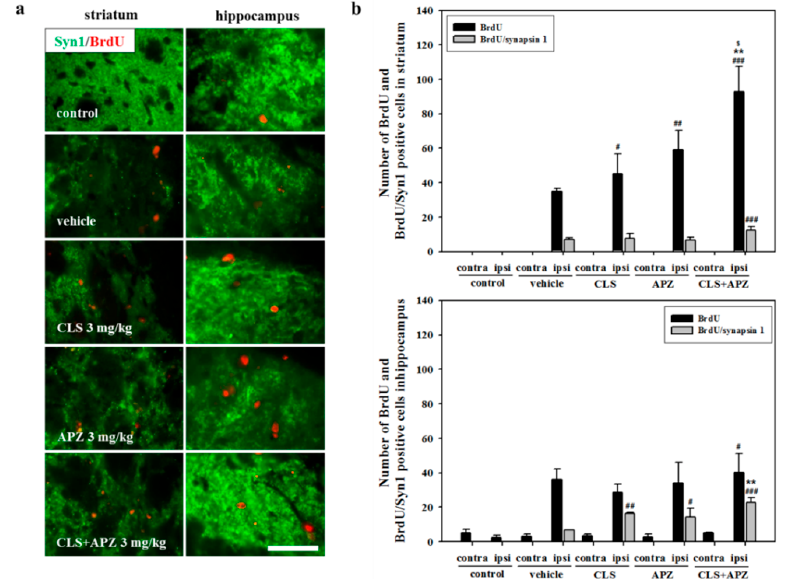
Figure 5. Effect of APZ augmentation on synaptic formation in proliferating progenitor cells in CLS-treated mice. Photomicrograph ( a ) and its histogram ( b ) for BrdU and BrdU/Syn1-double positive cells in the striatum and hippocampus ( n = 5). The combined use of APZ and CLS significantly increased the number of BrdU/Syn1-double positive cells in the hippocampus compared to the vehicle treatment. Contra, contralateral; ipsi, ipsilateral. # p < 0.05, ## p < 0.01 and ### p < 0.001 versus control mice; ** p < 0.01 versus vehicle-treated mice; $ p < 0.05 versus CLS-treated mice. Scale bars = 50 μ m.